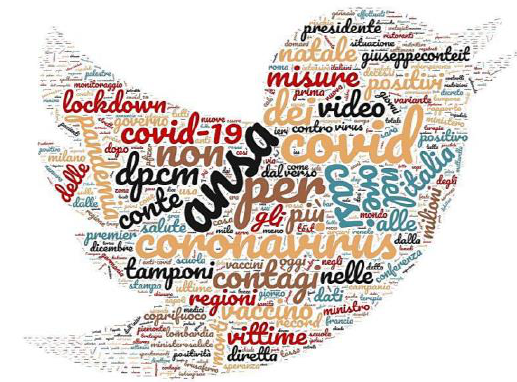
Figure 4. Word Cloud of the most frequent